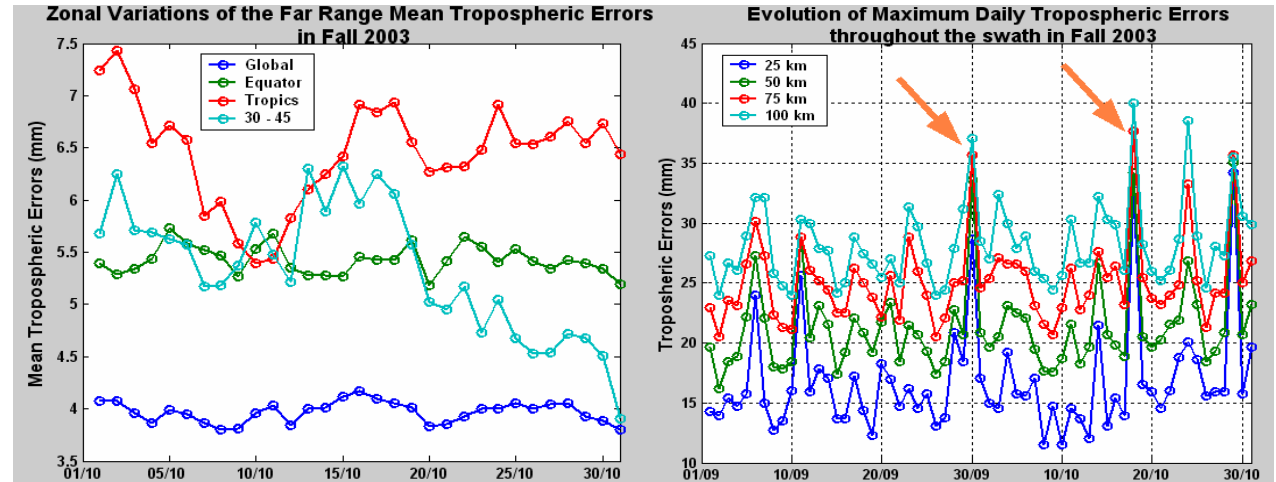
Figure 13. (a) Zonal variations of the Far Range mean tropospheric error in October 2003 (b) Worst cases tropospheric errors during fall 2003 with evidences of the Hurricane Juan (orange